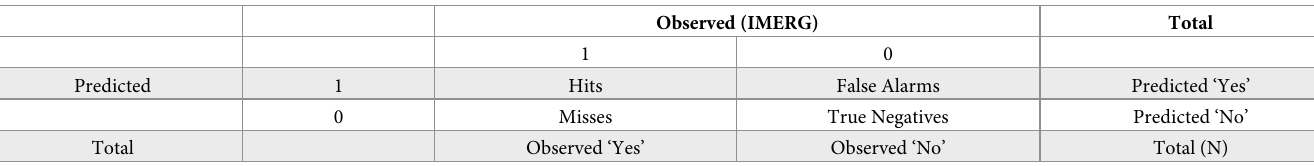
Table 5. Contingency matrix for the dichotomous